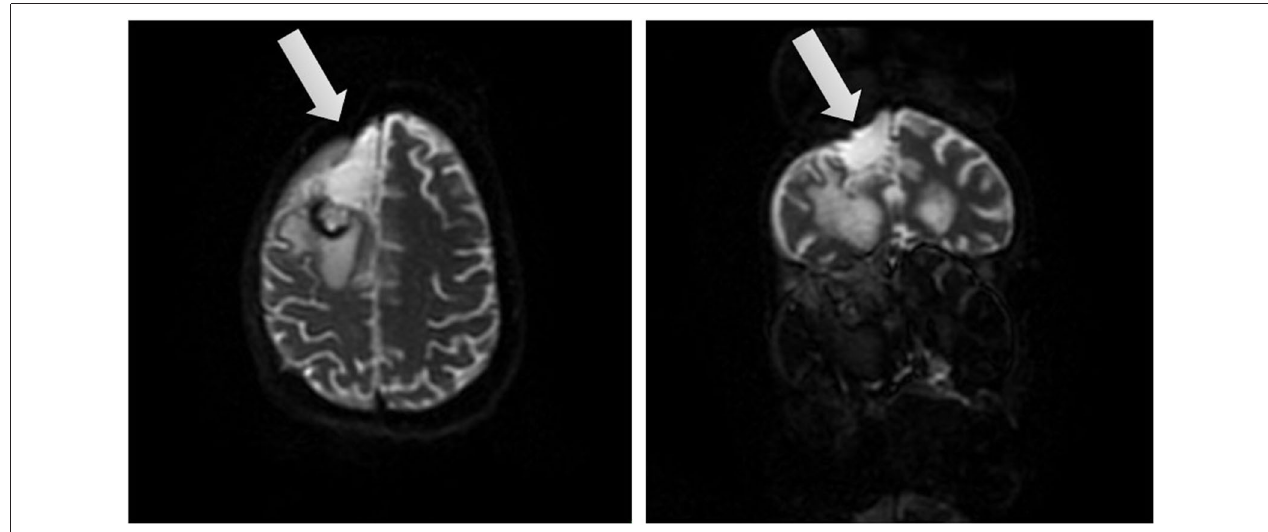
FIGURE 1 | Brain views after tumor removal . Two different views of the right frontal lobe upon removal of the tumor (affected area marked by arrow).